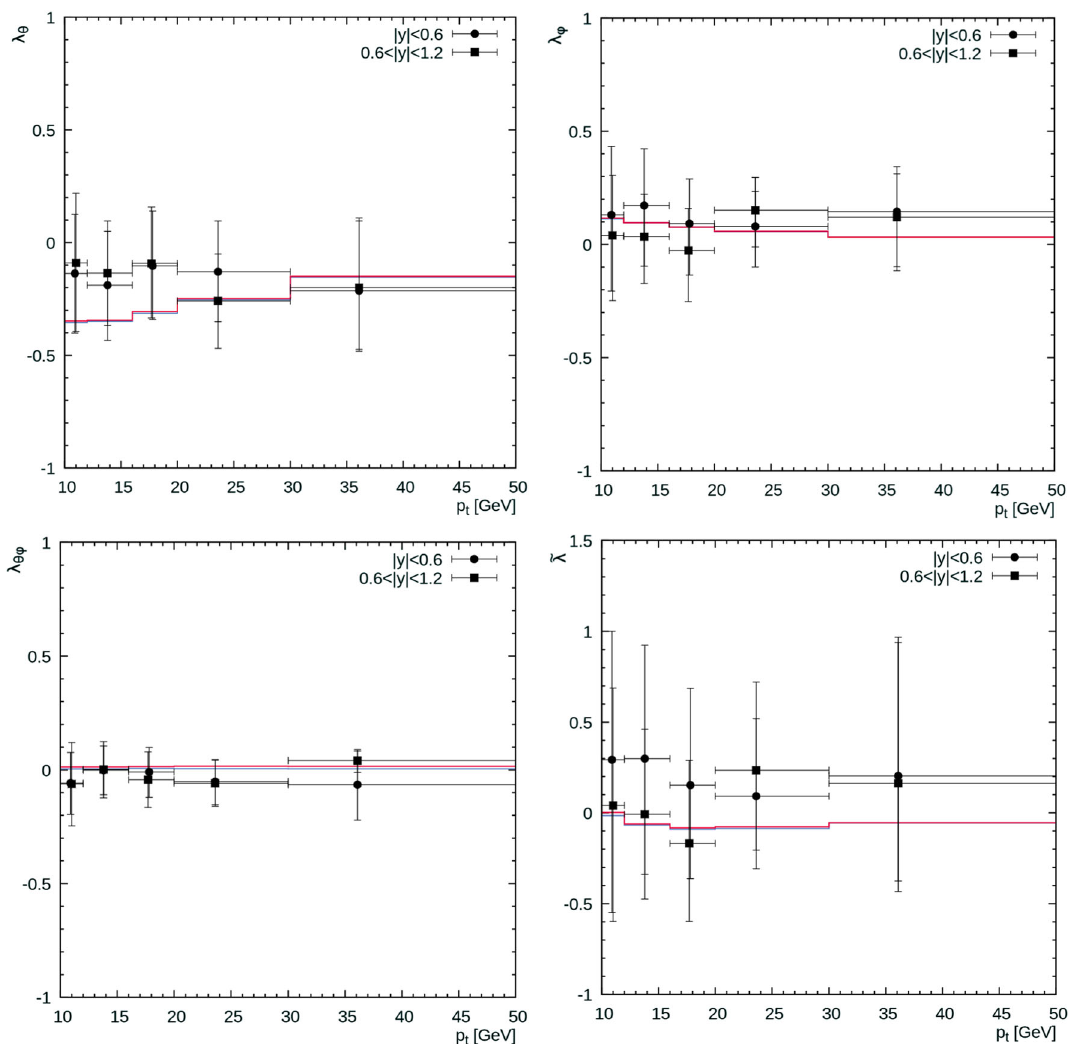
Fig. 6 Thepolarizationparameters λ θ , λ φ , λ θφ and ˜ λ of ϒ( 2 S ) mesons calculated in the CS frame as function of its transverse momentum at √ s = 7TeV.TheA0gluondensityisused.Theblueandredhistograms